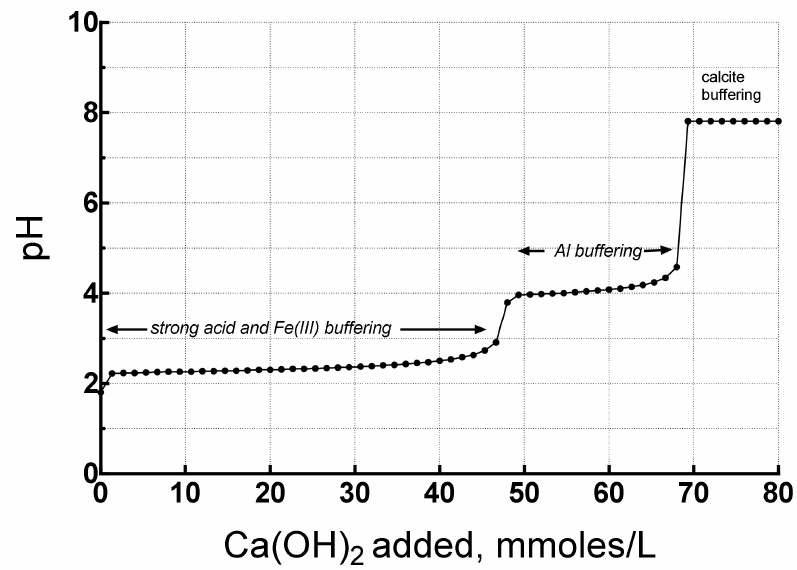
Figure 5. Titration simulation of acid mine drainage (AMD) from Leviathan Mine drainage by portlandite (slaked lime), showing the main bu ff ering mechanisms (similar to the mine tailings model,